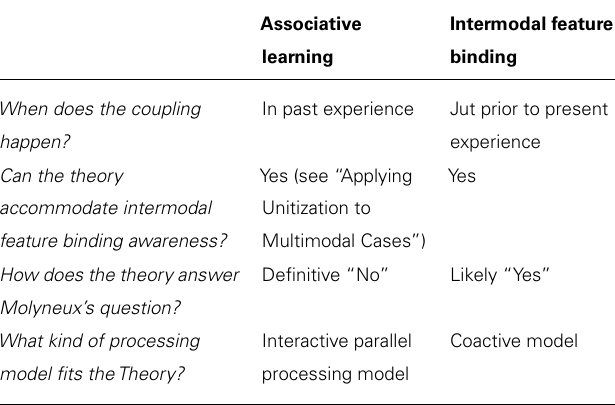
Table 1 | Multimodal perception: associative learning vs. intermodal feature binding.